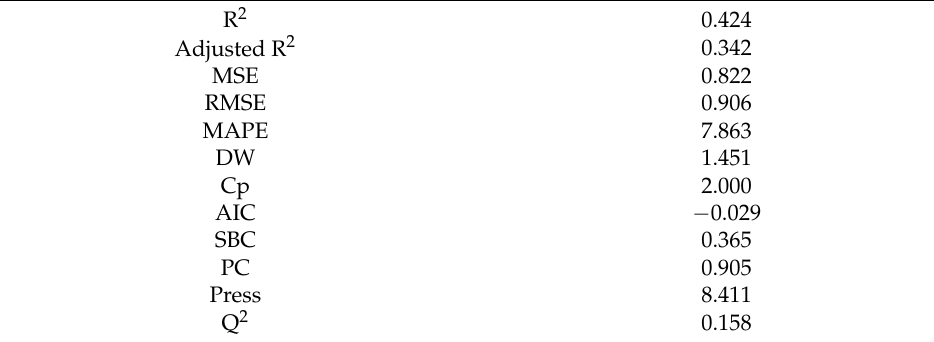
Table 3. Goodness of fit statistics (Autodock p K i